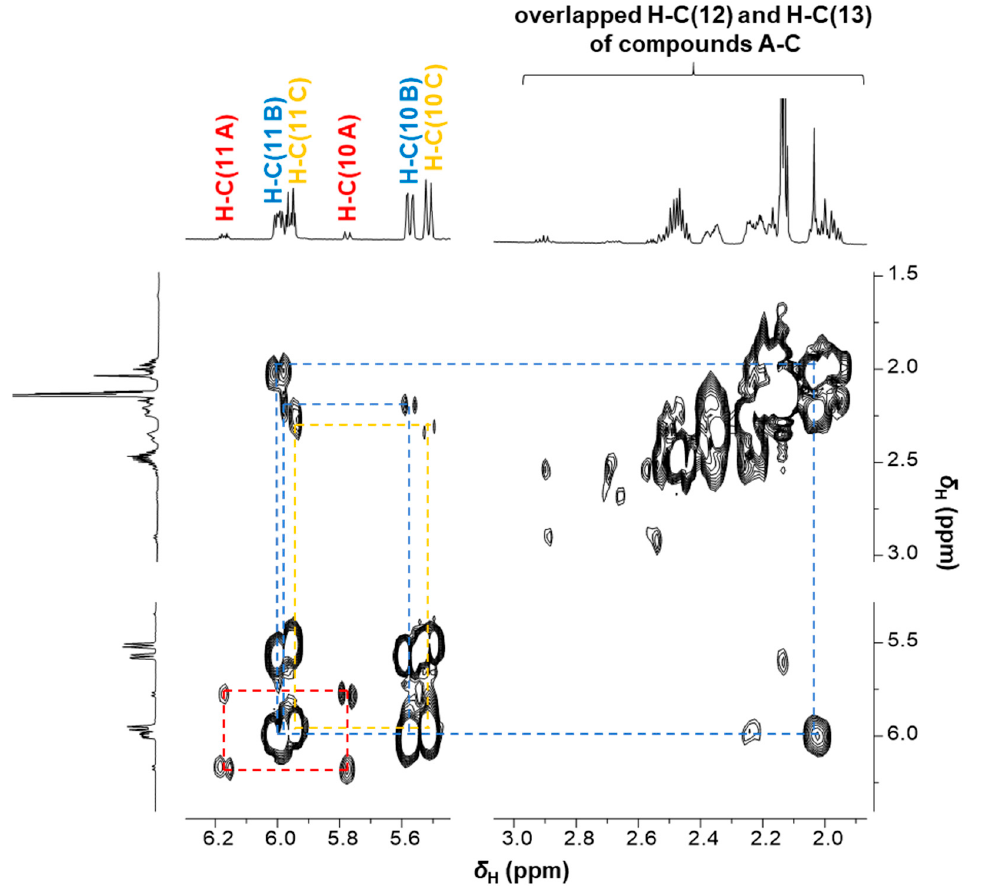
Figure 6. Excerpt of the COSY spectrum of fraction F7-4 indicating three compounds: A (red), B (blue), and C (yellow). The two-dimensional NMR spectrum shows the correlations of the protons H-C(10), H-C(11), H-C(12), and H-C(13).